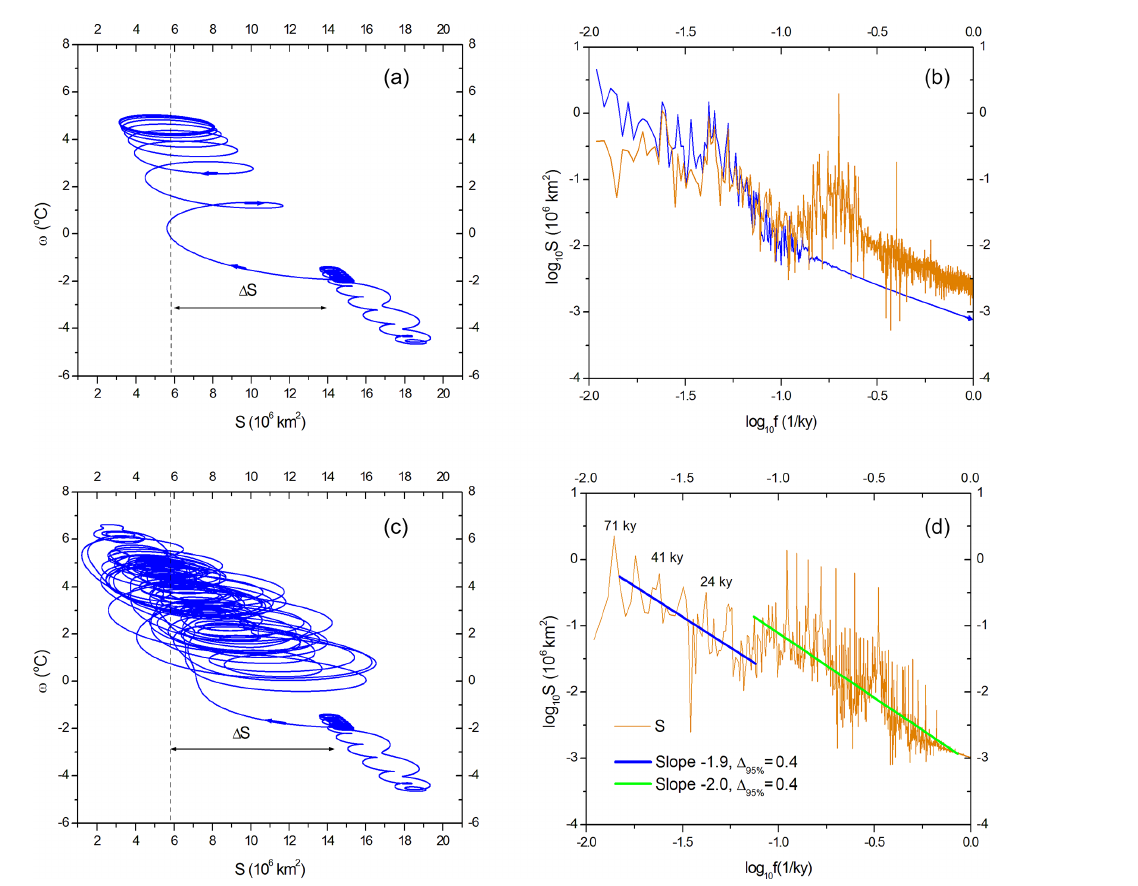
Figure 1. (a) The system response to pure 5kyr sinusoid of variable amplitude on a phase plane of glaciation area S (10 6 km 2 ) vs. climate temperature ω ( ◦ C); (cid:49)S is the disruption potential; (b) the blue line represents the reference system response to astronomical forcing (Verbitsky et al., 2018). Millennial forcing is absent here. The brown line shows the system response when the orbital forcing is combined with 5kyr sinusoid of the 10-fold amplitude. The diagram is a linear amplitude spectrum on a logarithmic scale; the vertical axis measures the amplitude of glacial area variations, log 10 [ S (10 6 km 2 )]; the horizontal axis is log 10 [ f (1kyr − 1 )]; (c) same as (a) but millennial forcing is formed by seven sinusoids of the same amplitude ( ∼ 2 . 5 of the insolation forcing amplitude) and periods of 3, 4, 5, 6, 7, 8, and 9kyr. (d) Same as (b) for multi-period forcing of (c)